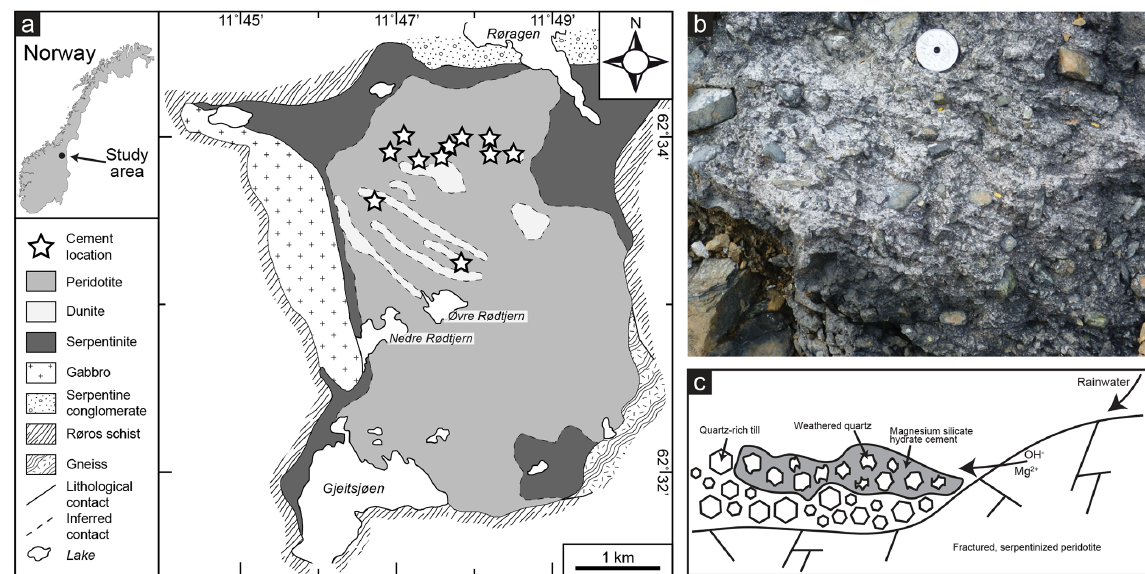
Figure 1. (a) Simplified geological map of the Feragen ultramafic body (after Moore and Hultin, 1980; Beinlich and Austrheim, 2012; de Ruiter and Austrheim, 2018). Note that felsic till is present on top of the bedrock. (b) Field photo of the cemented rock that occurs at multiple localities in the area consisting of magnesium silicate hydrate cement and quartz-rich grains. (c) Schematic (not to scale) overview of the formation of the cemented rock, showing that rainwater becomes high in pH and rich in Mg as it reacts with the brucite-bearing ultramafic rocks. As this alkaline fluid enters the quartz-rich till, it leads to the dissolution of quartz and precipitation of magnesium silicate hydrate cement at the outer layer of the